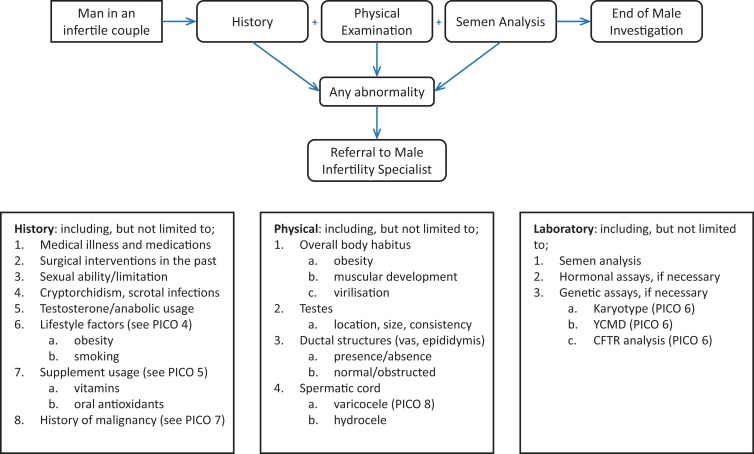
Flowchart summary of algorithm for diagnosis of male infertility. As detailed in section PICO 2 (Is it necessary for all infertile men to undergo a thorough evaluation?) the first line investigations should include Physical Examination, History and Semen Analysis. Abnormalities in these lead to further investigations. YCMD, Y chromosome microdeletion; CFTR, CF transmembrane conductance regulator.